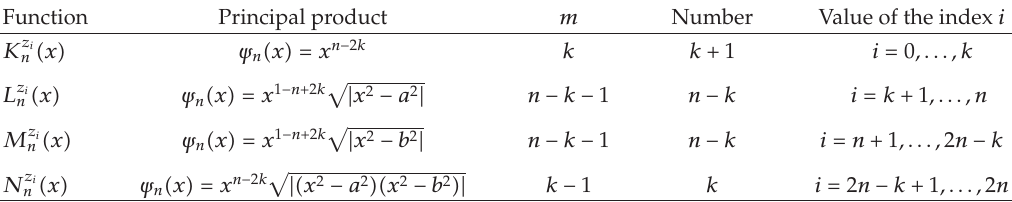
Table 1: Characteristics of lam´e’s functions of first